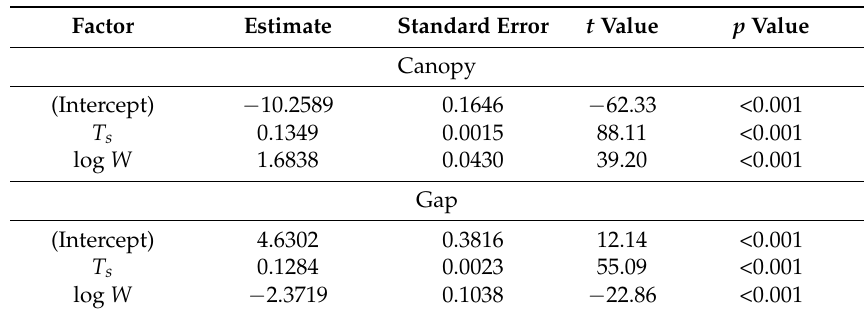
Table 2. Summary of the estimated coefficients in model 4, which was selected as the best model based on Akaike’s information criteria (AIC) in Table 1.